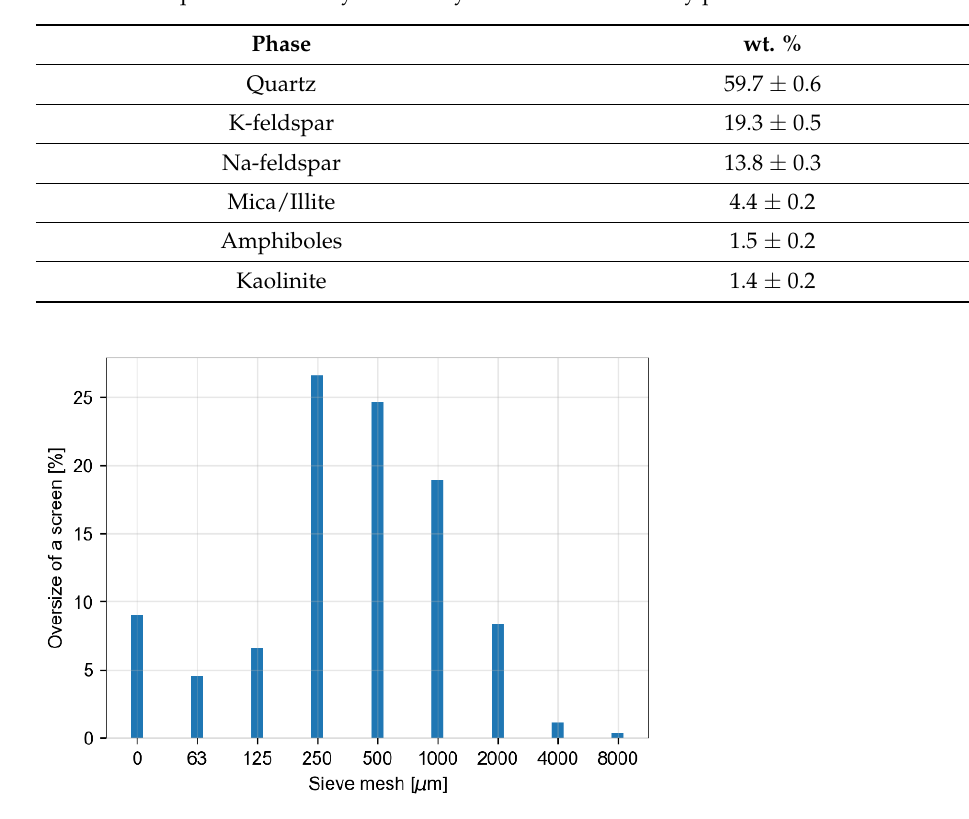
Table 1. XRD quantitative analysis of ready mixed earth-based dry product.